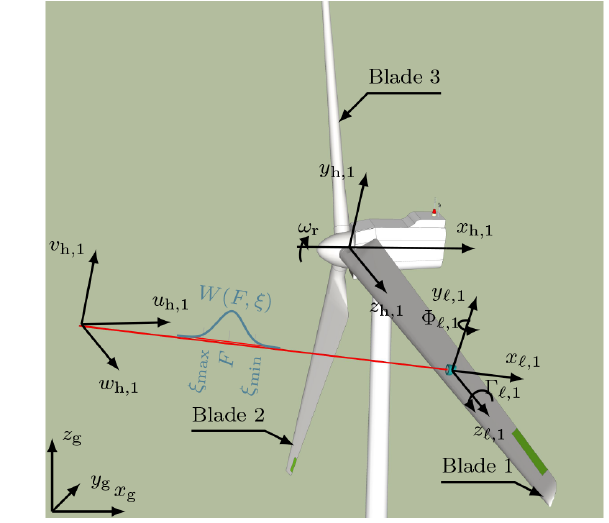
Figure 2. Configuration of the lidar measurement system, with a telescope mounted on each blade and connected to a continuous- wave lidar in the hub via fibre optics. The line-of-sight wind speed is computed on the basis of a weighting function ( W ( F , ξ )), which is dependent on the focus distance ( F ) and the range along the beam ( ξ